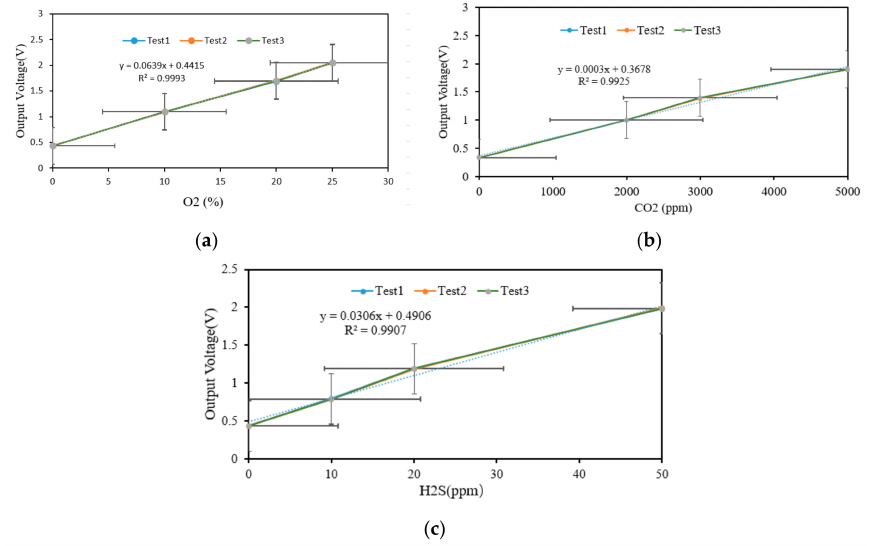
Figure 2. The sensors calibration curves: ( a ) O 2 sensors calibration curve; ( b ) CO 2 sensors calibration curve; ( c ) H 2 S sensors calibration curve. Note: x represents gas variables, y represents fitting equation, R 2 represents the correlation coe ffi